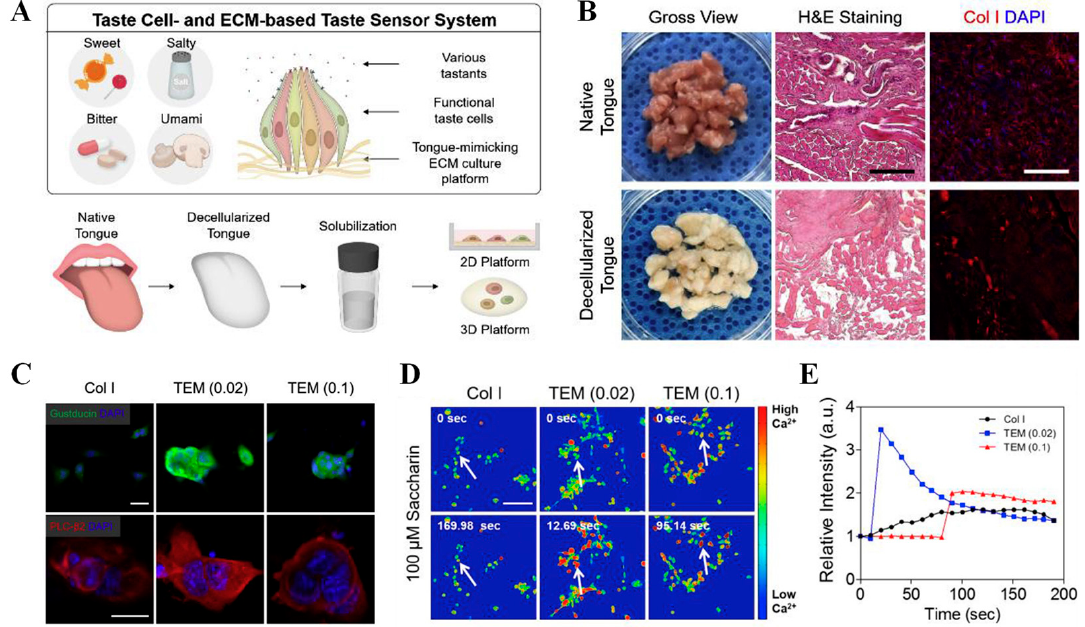
Figure 8. Preparation and sensing performance evaluation of TEM-based arti fi cial tongue. ( A ) Sche- matic image of taste cell- and TEM-based taste sensing systems; ( B ) characterization of tongue tissue matrix before and after decellularization; ( C ) immunostaining of taste cell-speci fi c markers, gustducin (green) and PLC- β 2 (red), on Col. I-based and TEM-coated 2D platform; ( D ) changes in calcium ion fl ux imaging of taste cells after treating with bi tt er compound saccharin; ( E ) imaging analysis of taste cells’ sensing performance. Reproduced from [129] with permission from Elsevier.